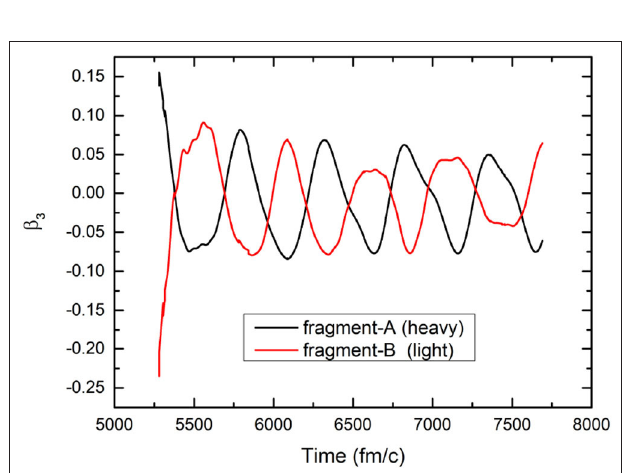
FIGURE 5 | The evolutions of octupole deformations in TDHF calculations of two fission fragments with the SV-sym34 force. The fragment-A is the heavy fragment and fragment-B is the light